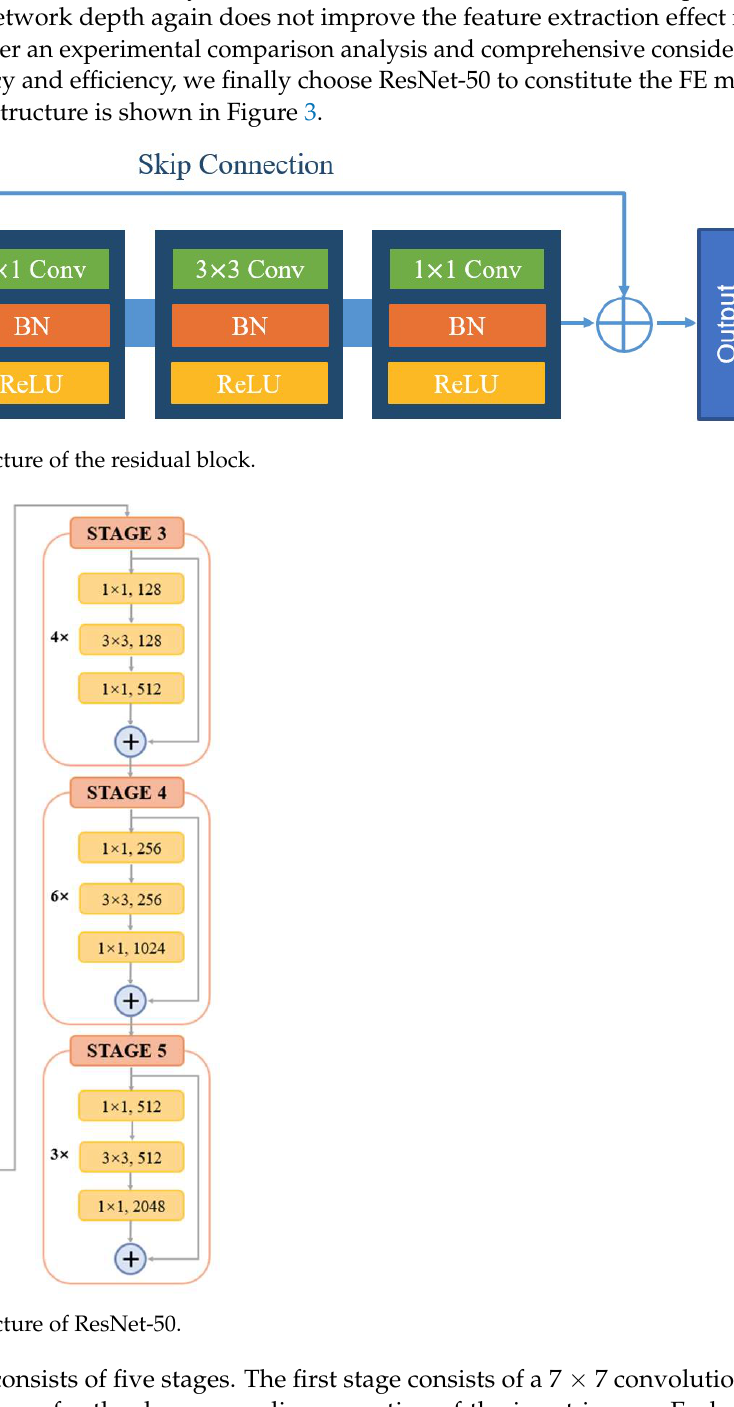
Figure 3. The structure of ResNet-50.